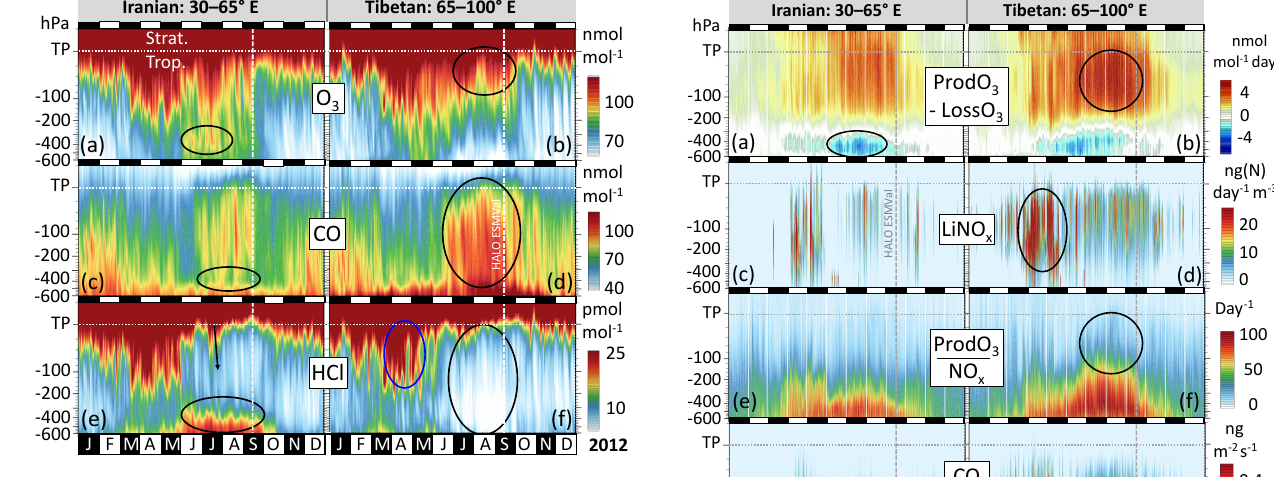
Figure 5. Evolution of simulated trace gas profiles in the western and eastern ASMA regions throughout 2012. The time of the HALO ESMVal measurements is indicated by a dashed line. Vertical coor- dinates are given as pressure distance to the tropopause (TP), whose altitude depends on time and location. All values are grid-cell dry air mass weighted averages from 15 to 35 ◦ N (see Fig. 2). Marked features are discussed in the text.